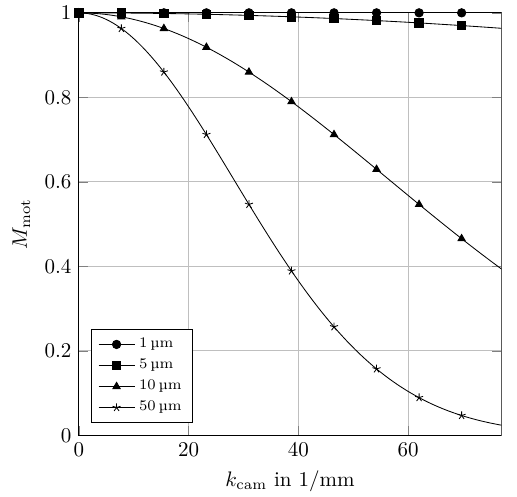
Figure 3. Motion blur MTF caused by camera motion in image space.